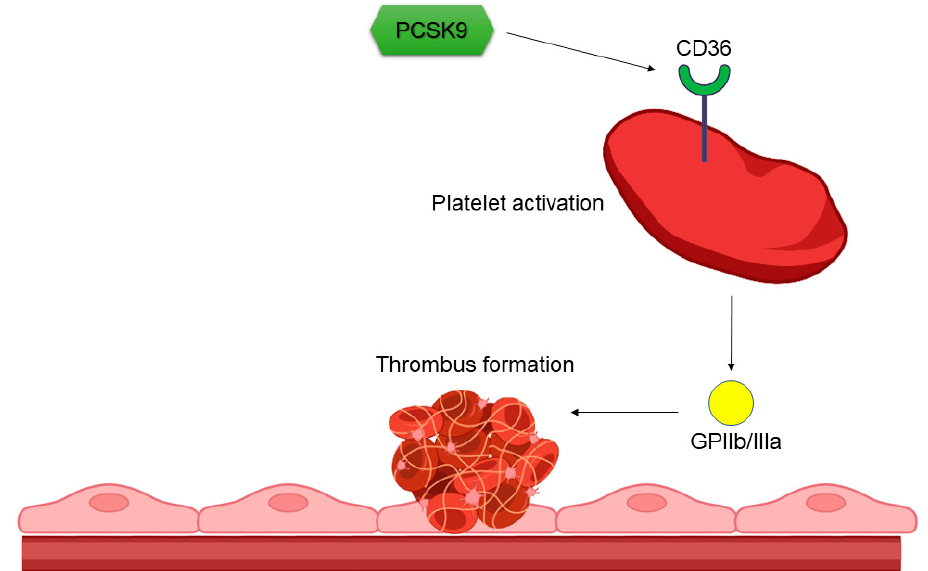
Figure 2. Influence of PCSK9 on platelet function. By binding to the CD36 receptor on a platelet’s surface, PCSK9 initiates a cascade reaction, resulting in GPIIb/IIIa formation, which enables increased platelet aggregation. PCSK9—proprotein convertase subtilisin/kexin type 9, CD36—cluster of differentiation, GPIIb/IIIa—glycoprotein IIb/IIIa.